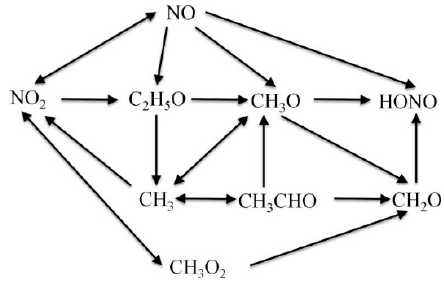
Figure 7. Reaction path of NO [24].